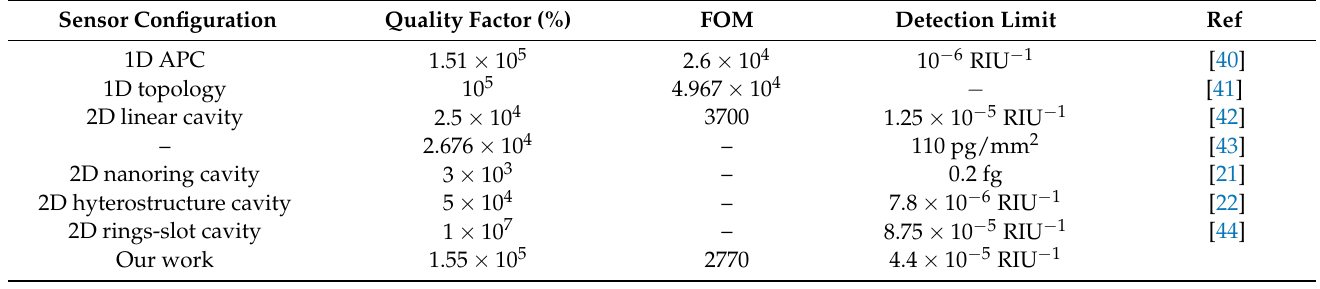
Table 2. Comparative analysis of cavities, topology, and heterogeneous structure in recent 1D and 2D PhCs sensors.